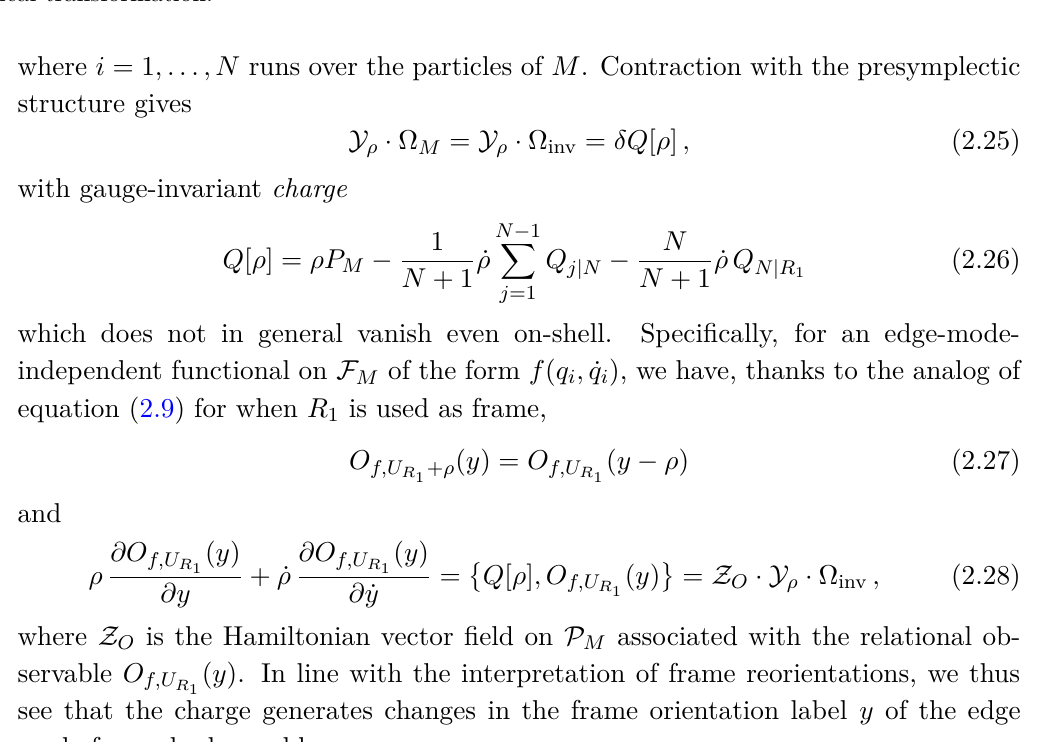
Figure 1 . Two types of transformations which are indistinguishable from their action on particles in region M , but distinguishable relative to the dynamical frame R . The vector field X (top) moves 1 α both the particles in M and the frame R by the same distance, therefore does not affect relative 1 distances and corresponds to a gauge direction. The symmetry (frame reorientation) generator Y ρ (bottom) only acts on R , thereby affects relative distances to the reference frame: it generates a 1 physical